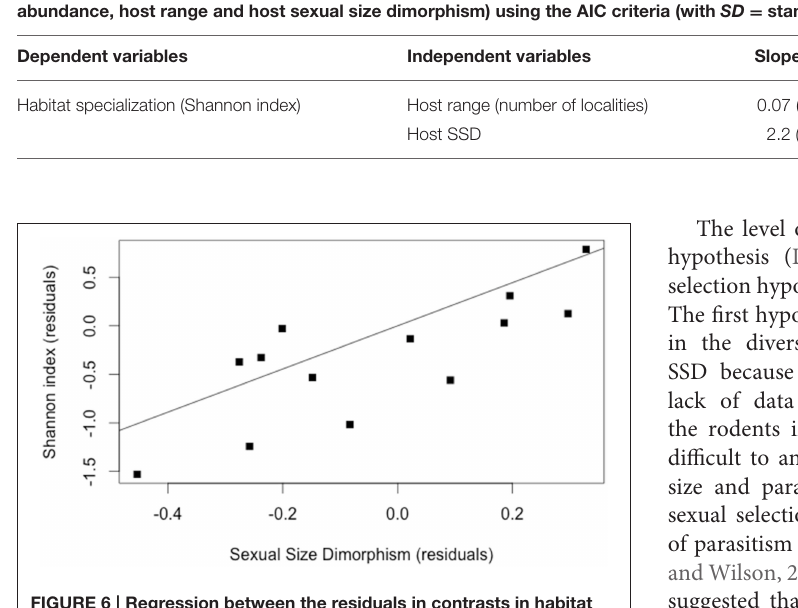
FIGURE 6 | Regression between the residuals in contrasts in habitat specialization (using Shannon index) and residuals in contrasts in sexual size dimorphism (controlling for host range, using the model of Table 6); ( R 2 = 0.57 , P = 0 .002).